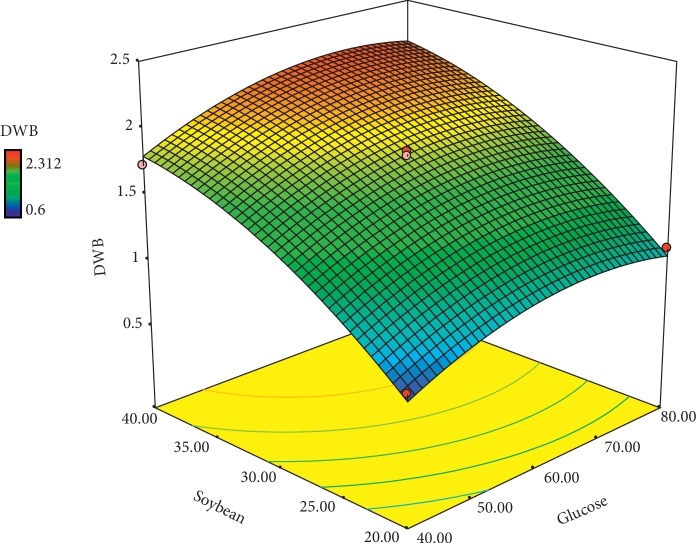
Response surface curve for DWB production by M. fluvialis.